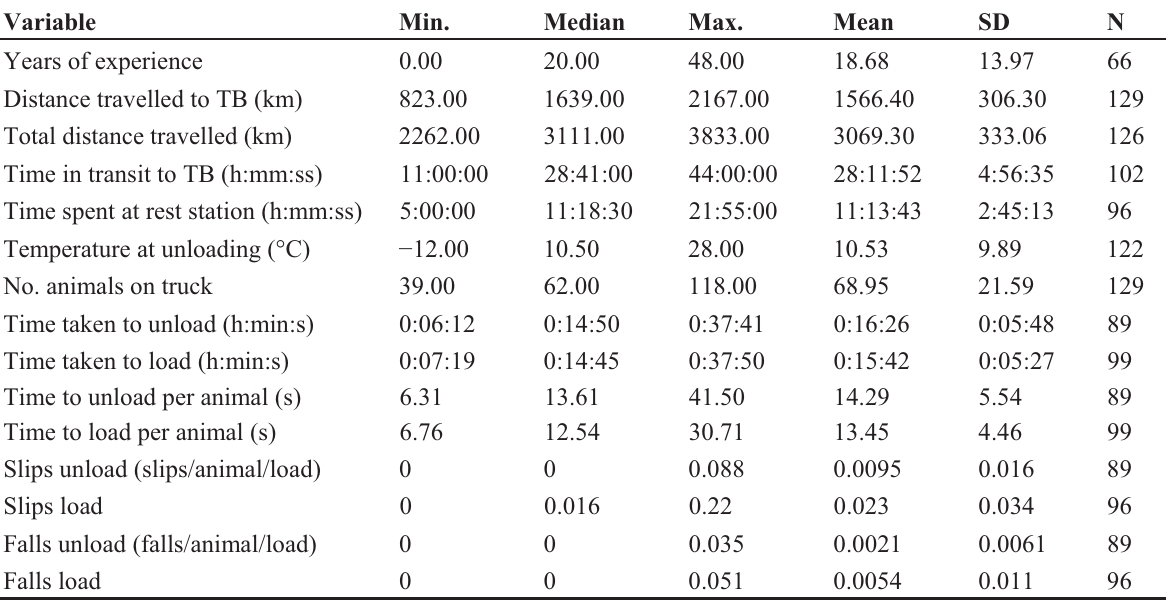
Table 2. Continuous variables collected for loads of cattle stopping for feed, water and rest near Thunder Bay, ON